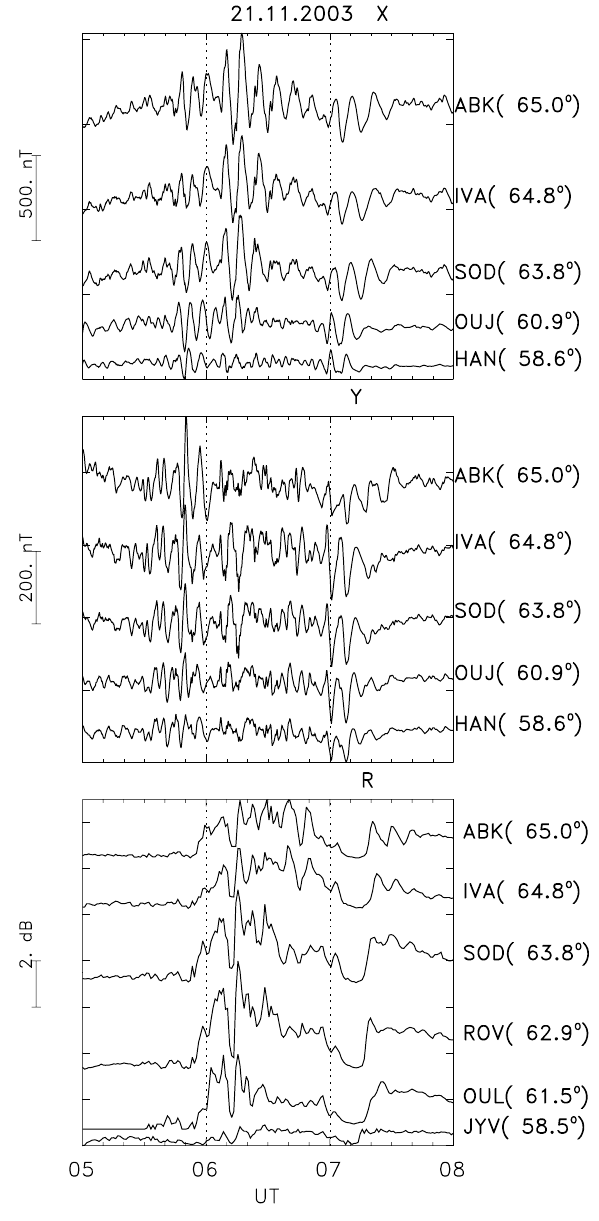
Fig. 3. The X and Y components of magnetic field variations and riometer data (bottom) at the selected Finnish stations in the time interval 04:00–08:00 UT on 21 November 2003. were observed. However, at 05:55-06:15 UT an enhance- ment in precipitation was observed at all stations. After 06:00 UT practically each burst of PiB pulsations had a one- to-one correspondence to the absorption peaks. The best cor- relation between the PiB and precipitation was observed at SOD, where the strongest PiB pulsations occurred. The PiB pulsations at all stations, as well as the bursts of auroral radio absorption, suddenly decreased at about 07:00 UT, when the solar wind density abruptly